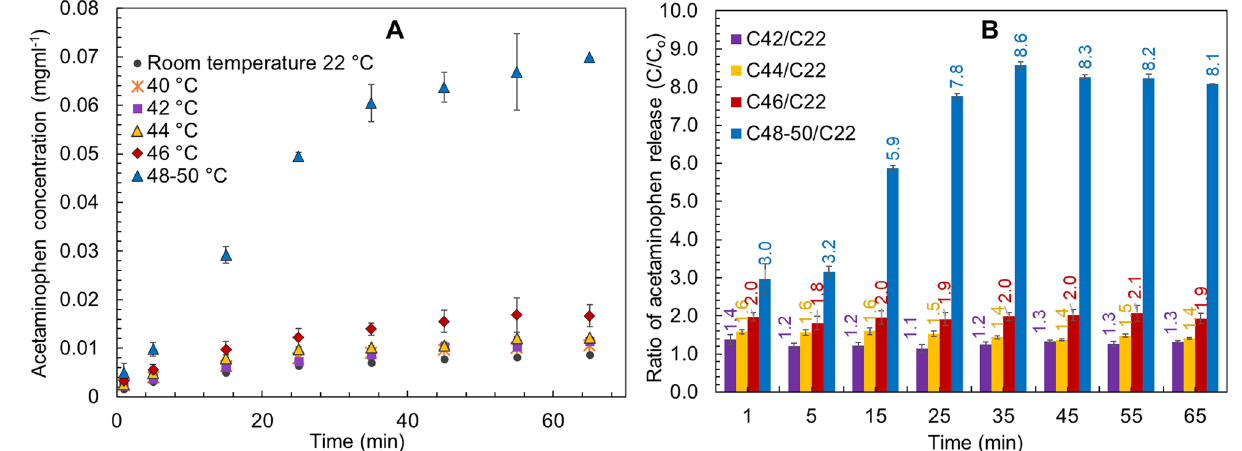
Figure 3. Results for acetaminophen (Ac) release with time from disc shaped gels. ( A ) Concentration of Ac released for disc shaped gels at 22 (r.t.) 40, 42, 44, 46 and 48–50 °C. ( B ) Ratio of Ac released at all temperatures compared to room temperature (i.e., (C40/C22 = concentration at 40 °C/concentration at 22 °C etc.).